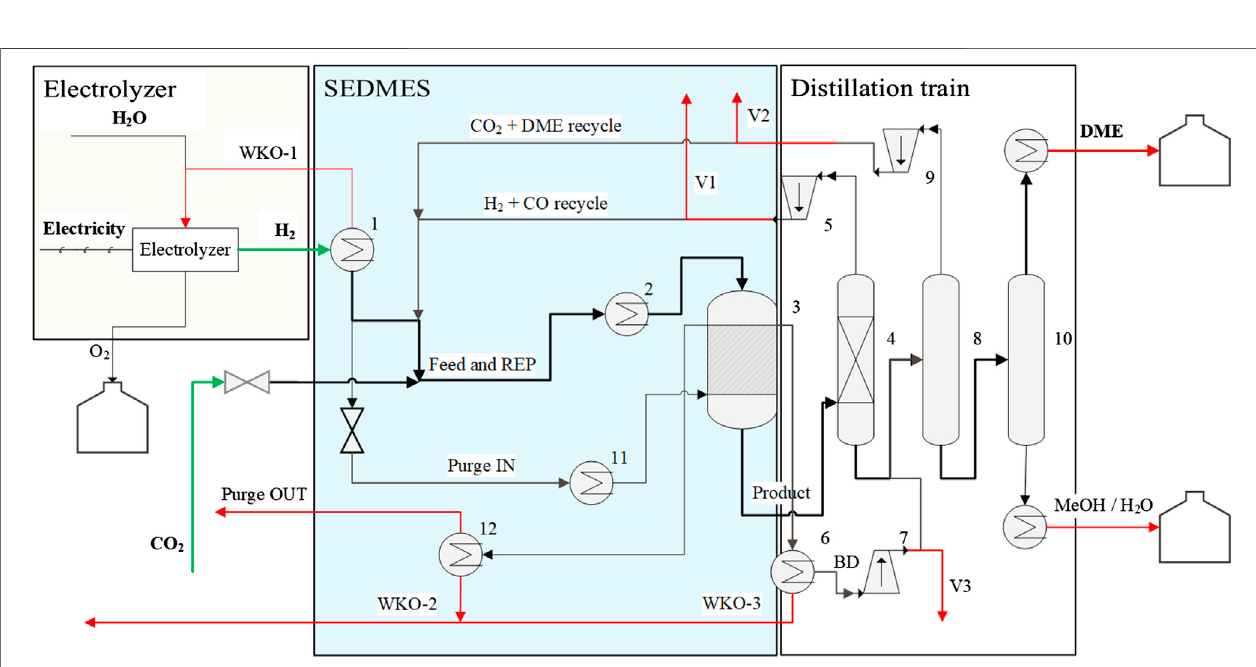
FIGURE 3 | Flow sheet of the power-to-X technology sorption-enhanced dimethyl ether synthesis process, including the following main equipment: 1: heat exchanger for H 2 dehumidi fi cation (cooling); 2: heat exchanger for the feed to reach operating temperature; 3: sorption-enhanced dimethyl ether synthesis columns; 4: fl ash drum toremovenoncondensables; 5: blower for recycling ofnoncondensables; 6: heatexchanger todehumidify blowdown stream; 7: compressor for blowdown; 8: distillation column for CO 2 separation (DSP-1); 9: compressor for recycling of CO 2 ; 10: distillation column for DME/MeOH + H 2 O separation (DSP-2); 11: heat exchanger for purge dehumidi fi cation (cooling); 12: heat exchanger for purge stream (heating).